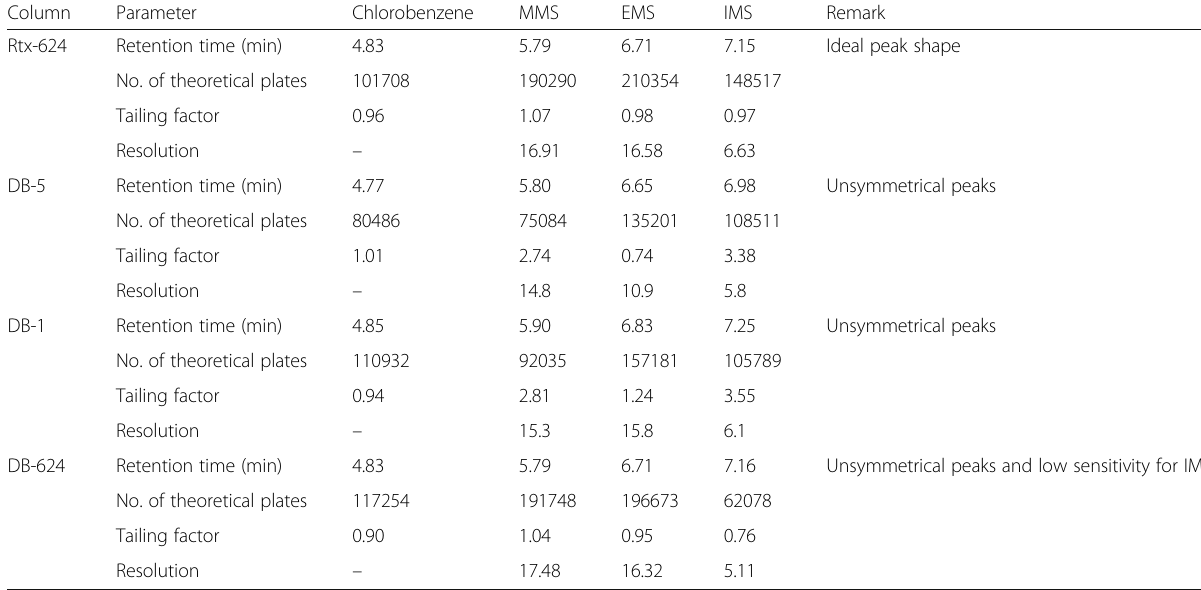
Table 2 Chromatographic performance data